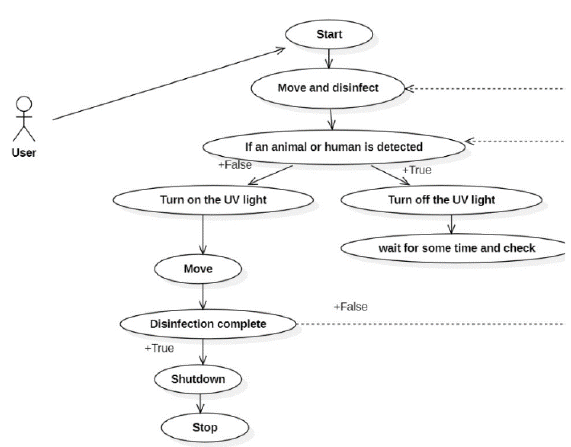
Figure 7. Use Case Diagram